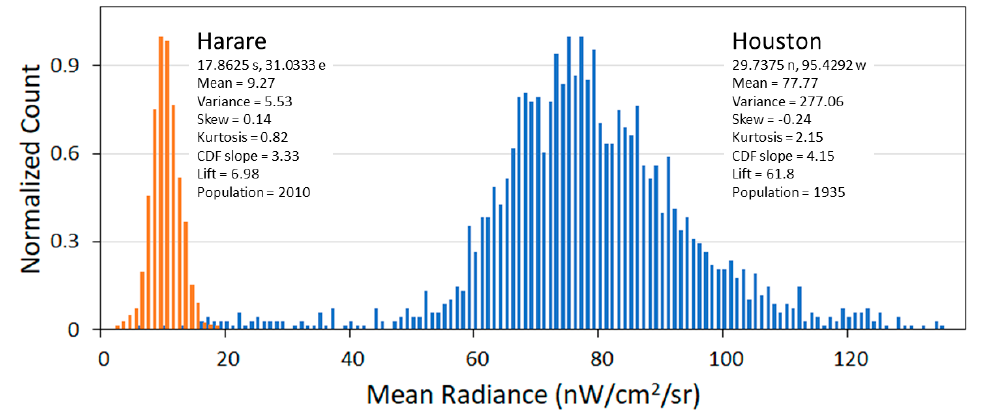
Figure 11. DNB histograms for the Houston and Harare points from Figure 10. The two distributions are nearly 100% are nearly 100% disjointed.